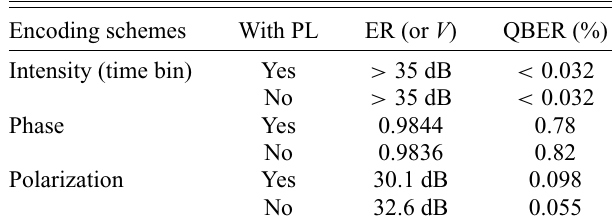
TABLE I. Summary for the extinction ratio (ER) or visibility ( V ) and QBER for different encoding schemes with and without